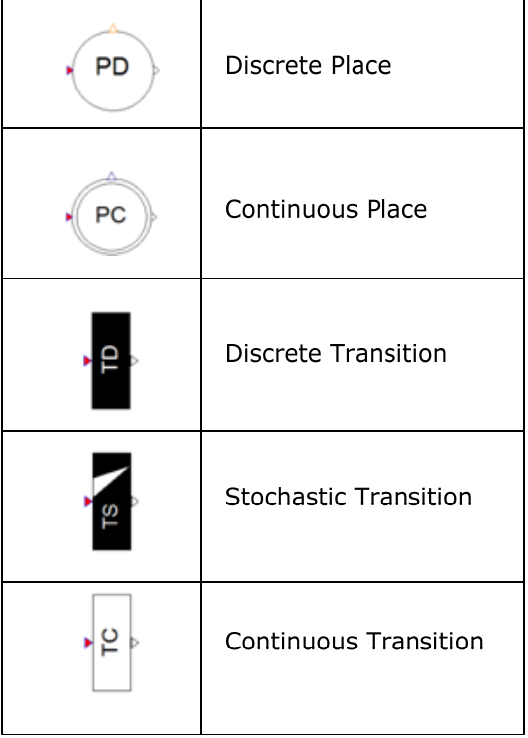
Figure 5: Icons of the Petri Net